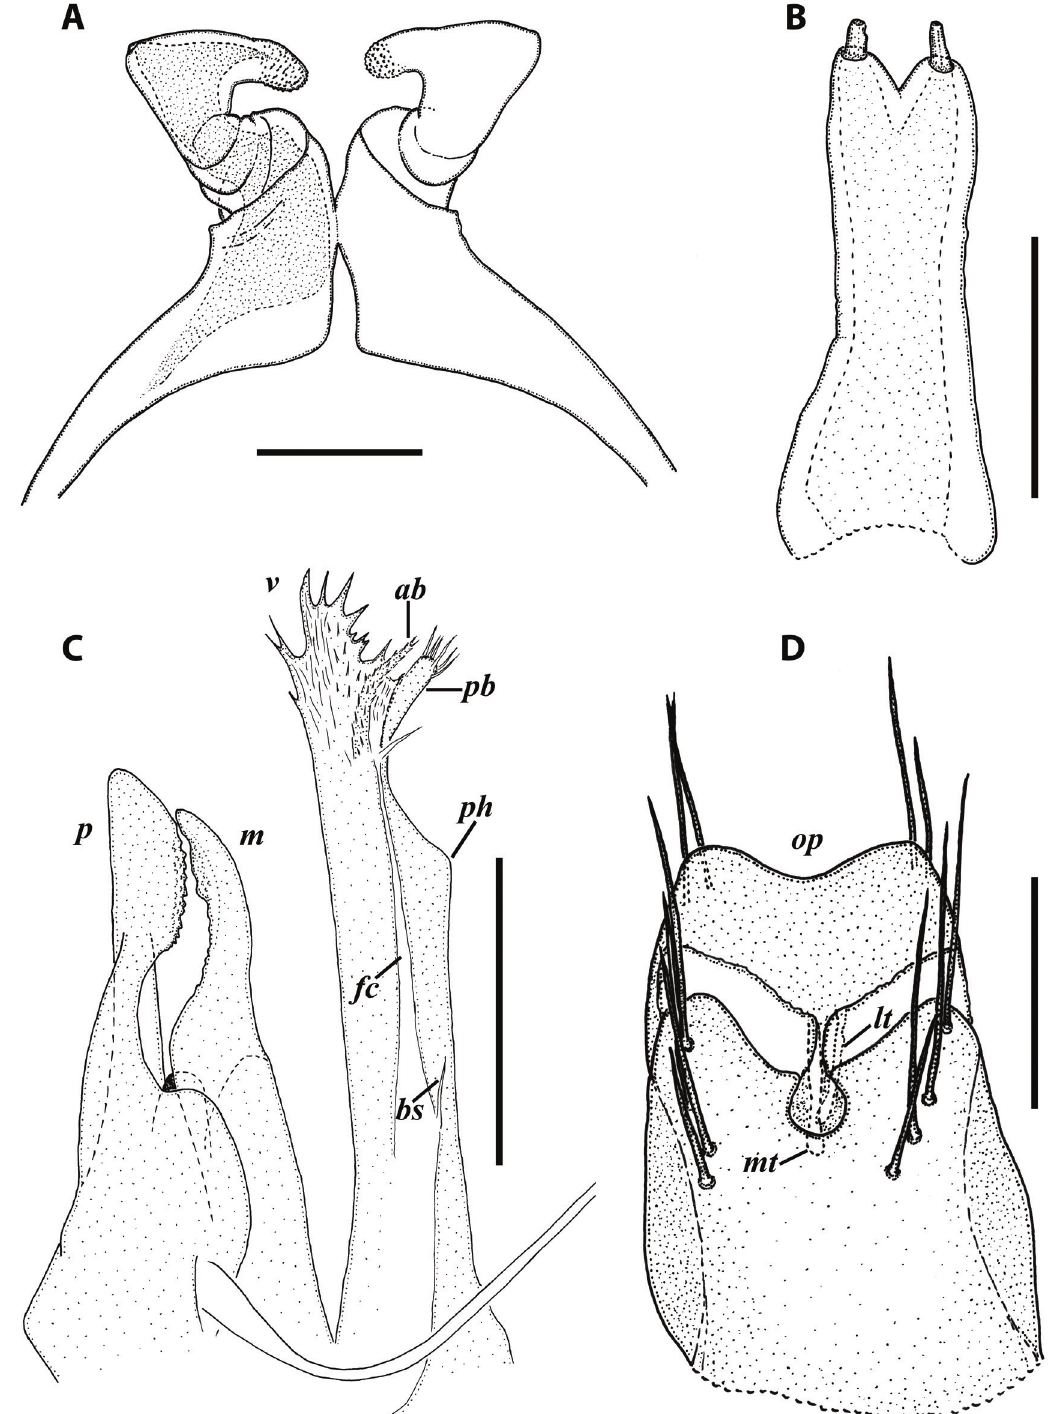
Fig. 3. Stygiiulus fimbriatus (Strasser, 1971) comb. et stat. nov., holotype ♂ (A, B) (MHNG), ♂ (C) (IZB) and ♀ (D) (IBER) from Foran di Landri Cave. A . Leg-pair 1, caudal view. B . Penis, oral/caudal view. C . Left gonopods, mesal view. D . Left vulva, caudal, somewhat mesal view. Abbreviations: ab = anterior branch of solenomere; bs = basal spine; fc = flagellum channel; lt = lateral tube; m = mesomere; mt = median tube; op = operculum; p = promere; pb = posterior branch of solenomere; ph = posterior hump; v = velum. Scale bars = 0.2